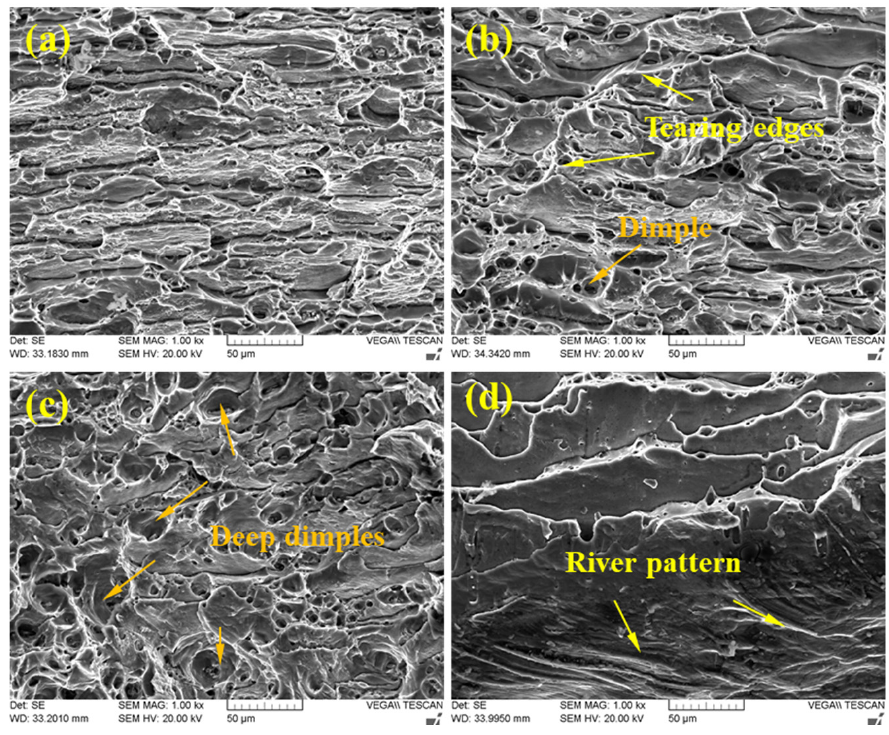
Figure 9. SEM images of fracture surface for different tensile test joints: ( a ) 90 mm/min; ( b ) 120 mm/min; ( c ) 150 mm/min; ( d ) 180 mm/min.